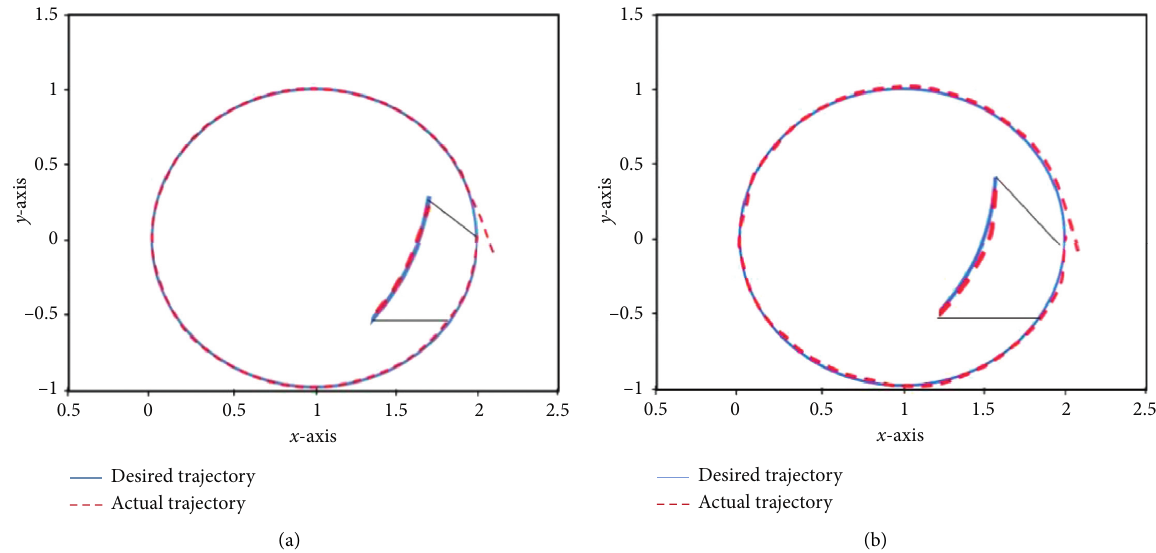
Figure 6: The desired and actual orbicular trajectory of DDMR. (a) Trajectory tracking with NNFOPID controller and (b) trajectory tracking with NNPID controller.